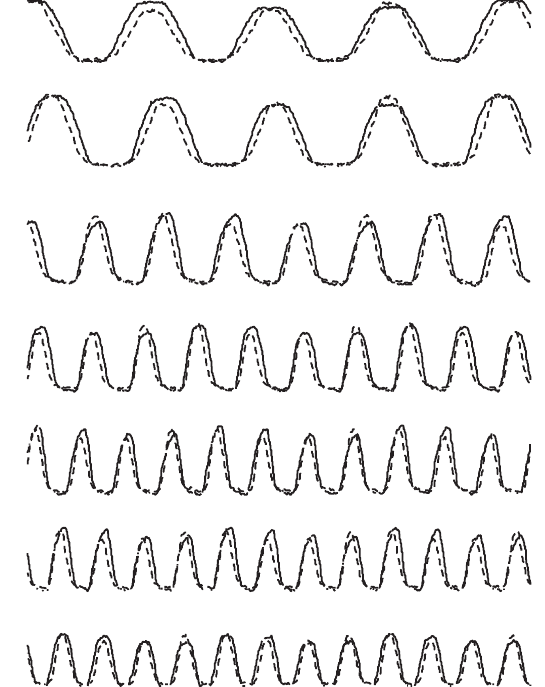
FIG. 9. Bunch profiles during acceleration process for single- harmonic acceleration (dashed line), and dual-harmonic accel- eration (solid line). In the horizontal direction, the time scale is in the order of microseconds whereas several traces are omitted in the vertical direction such that several tens of milliseconds are visible.